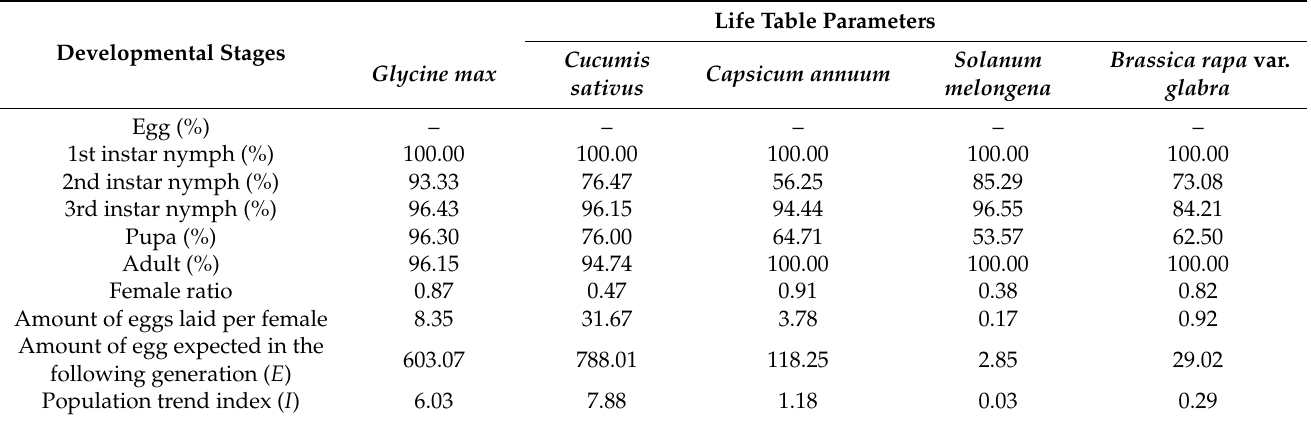
Table 1. Life table parameters of Thrips flavus fed on different plants.